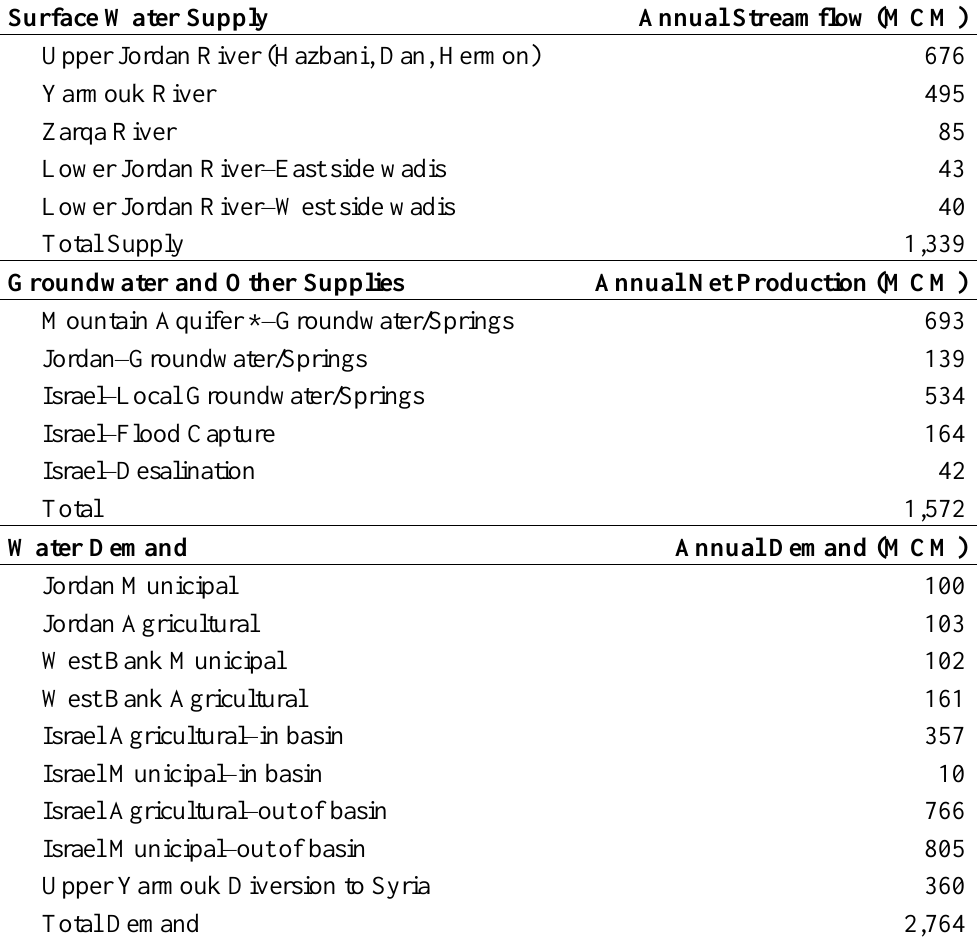
Table 1. Approximate water budget for average year (see data section further below for period over which averaging took place and for details on the method used (in million m 3